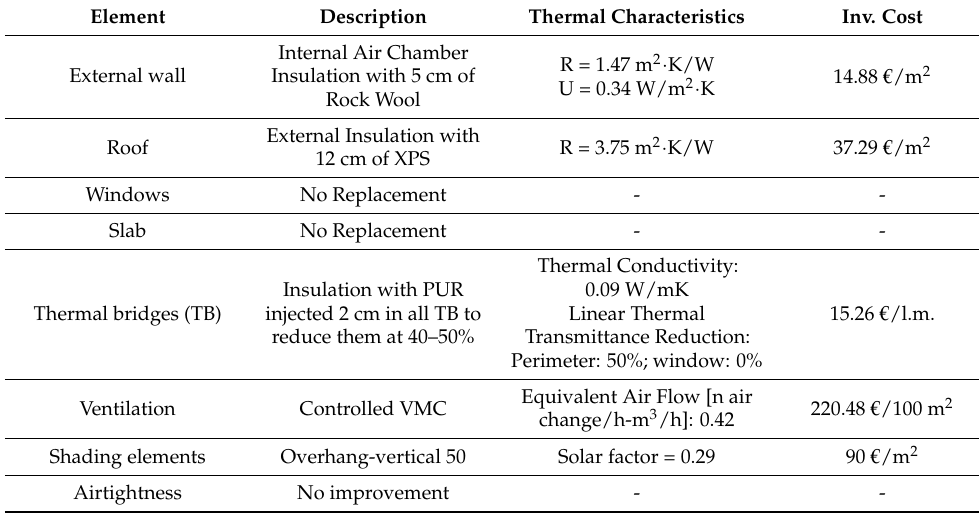
Table A3. POS4s: Renovation measures of solution 4.